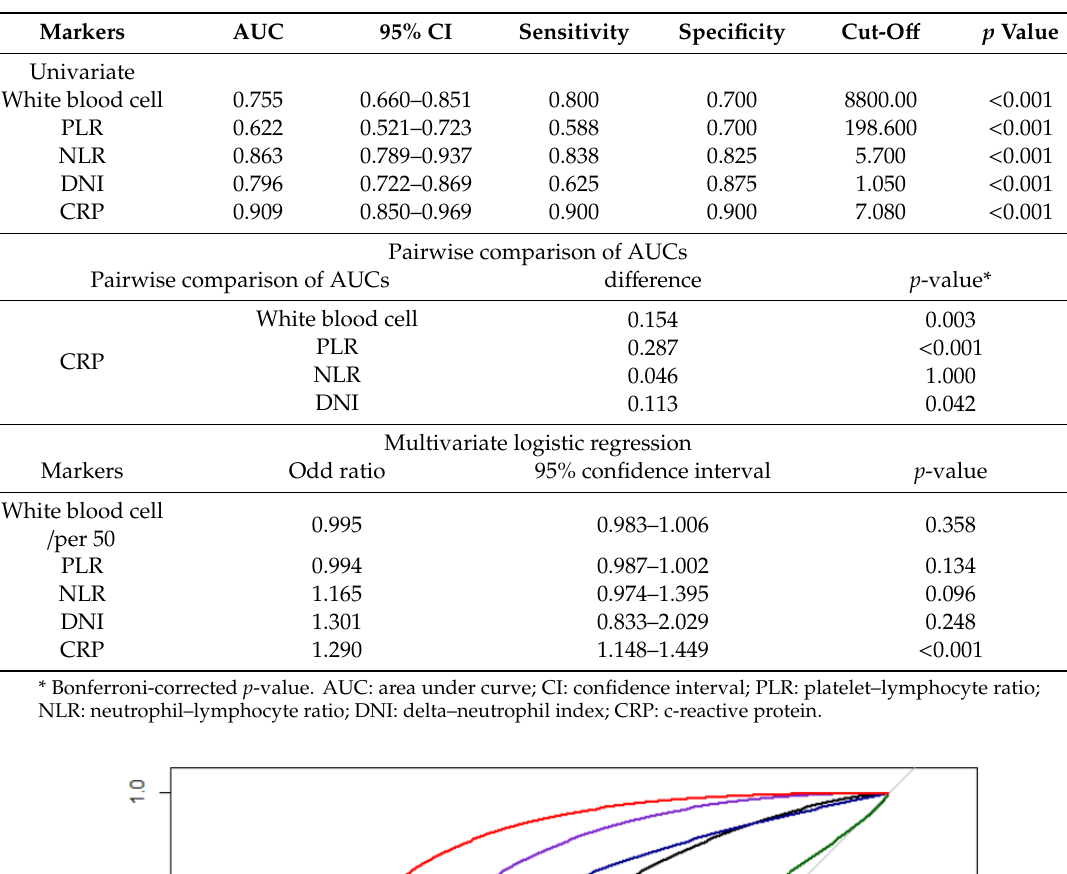
Comparison of inflammatory markers in discrimination of liver abscess from cholangiocarcinoma.